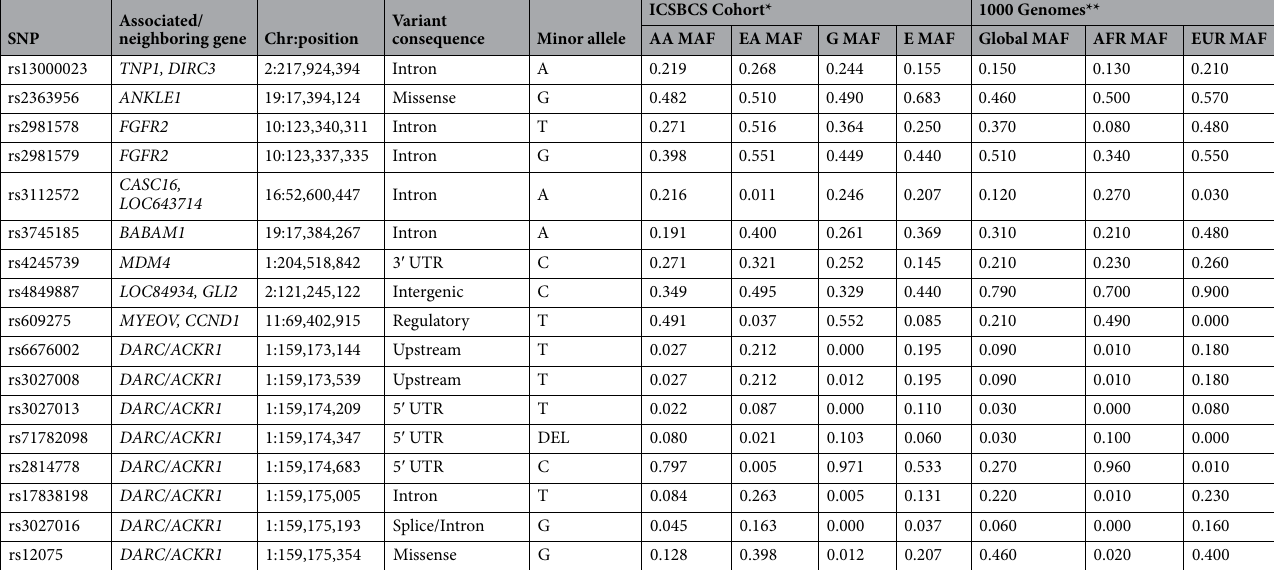
Table 1. Population frequencies of candidate alleles for BC and TNBC-specific risk analyses. *African Americans (AA), European Americans (EA), Ghanaians (G), Ethiopians (E). *MAF = Minor allele frequency. **1000 Genomes Allele frequencies obtained from ensemble.